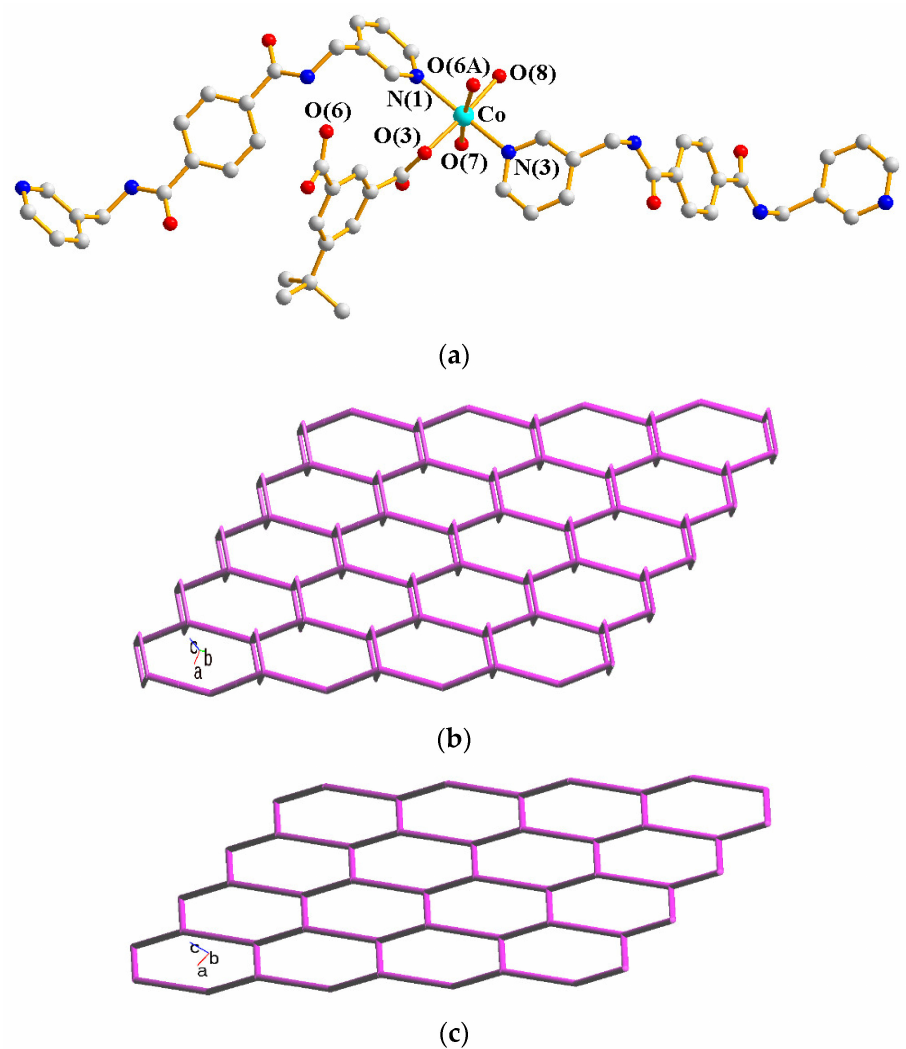
Figure 2. ( a ) A drawing showing the geometry of the Co(II) ion in 1 . Symmetry transformations: (A) –x + 1, − y + 1, − z. ( b ) A drawing showing the (12)(4 · 12 5 )(4) topology. ( c ) A drawing showing the hcb